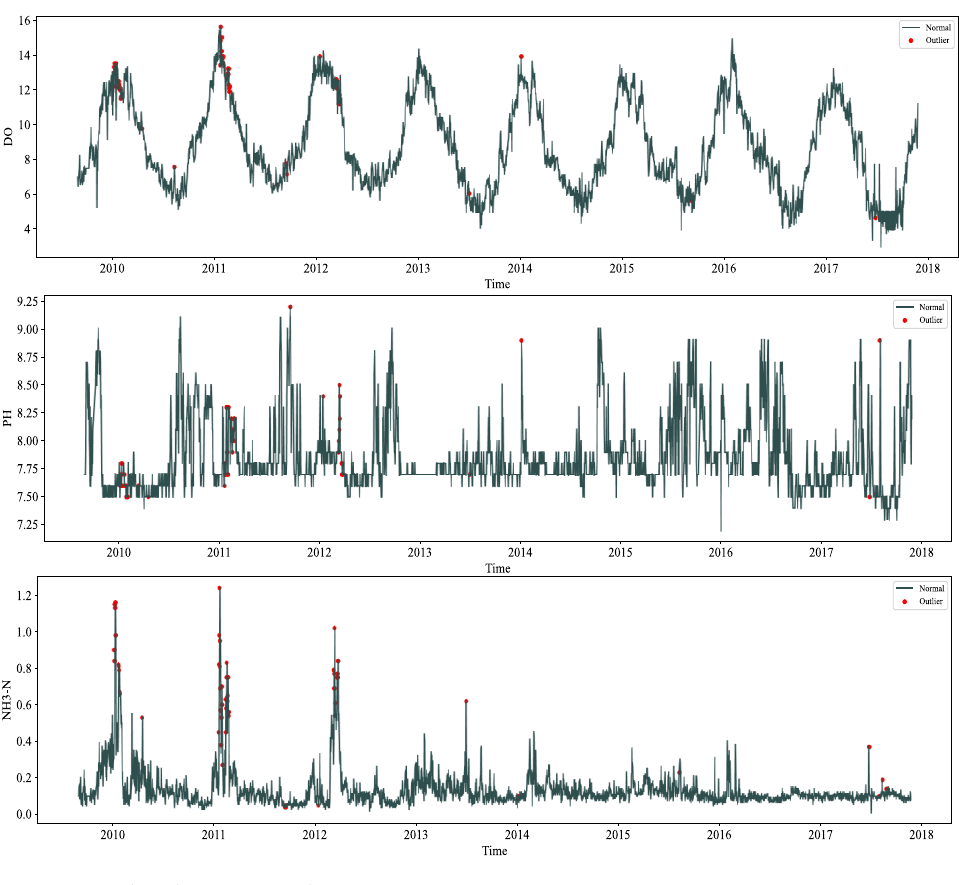
Figure 6. Outlier detection results.